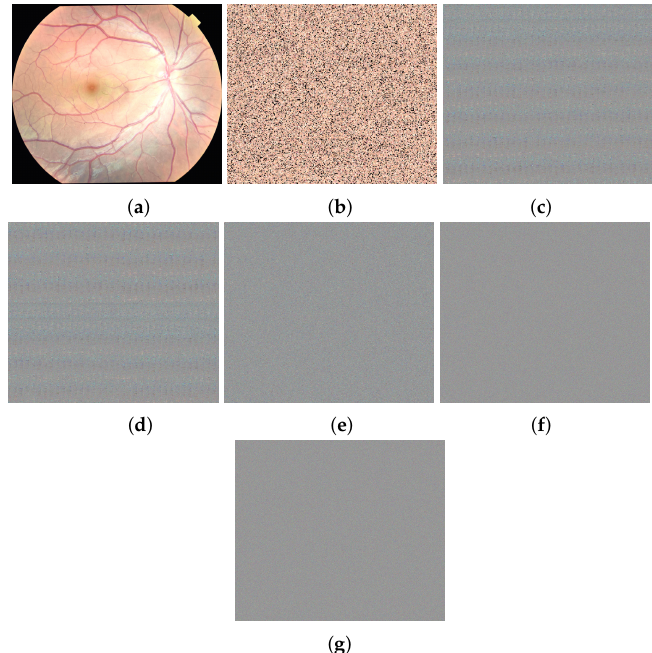
Figure 12. Results of the encryption algorithm applied to image 6 from the healthy